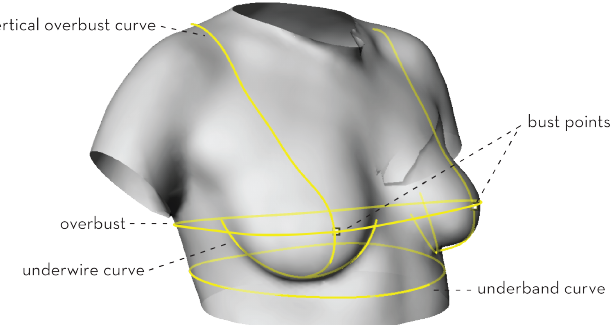
Figure 3. Diagram showing landmarks visualized in a sample output image.